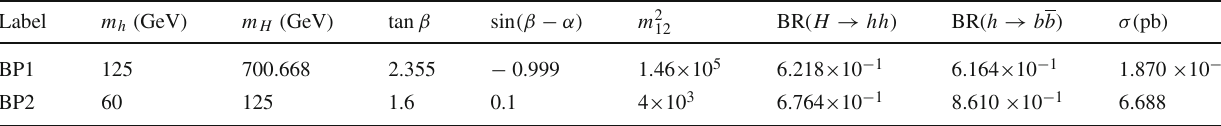
Table 1 The 2HDM-II parameters and cross sections of the process in Fig. 1 for each BP Label